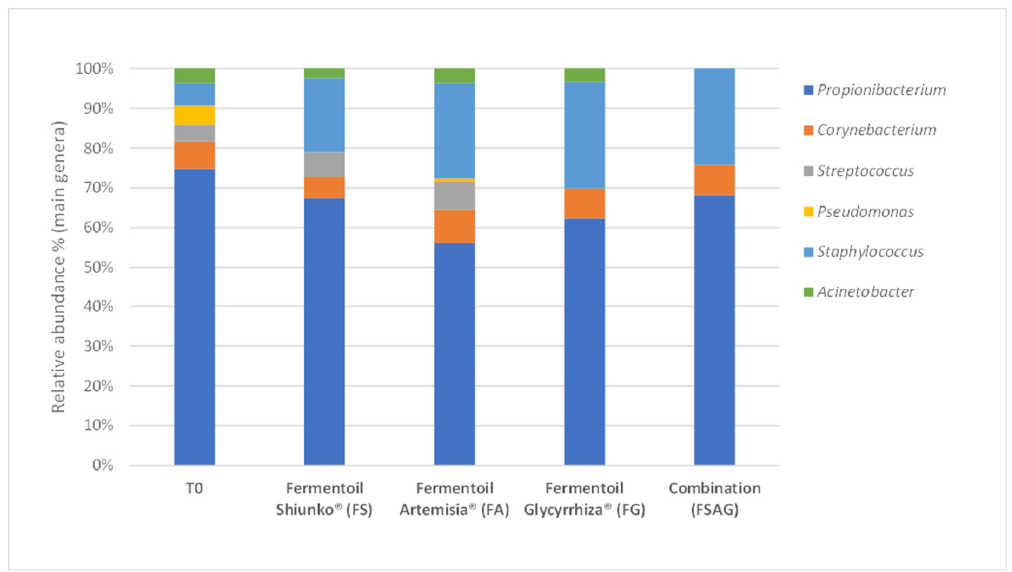
Figure 3. Semi-quantitative bacterial composition: relative abundance at genus level. (a) T0; (b) F-Shiunko (FS) at T1; (c) F-Artemisia (FA) at T1; (d) F-Glycyrrhiza (FG) at T1; (e) combination (FSAG) at T1.